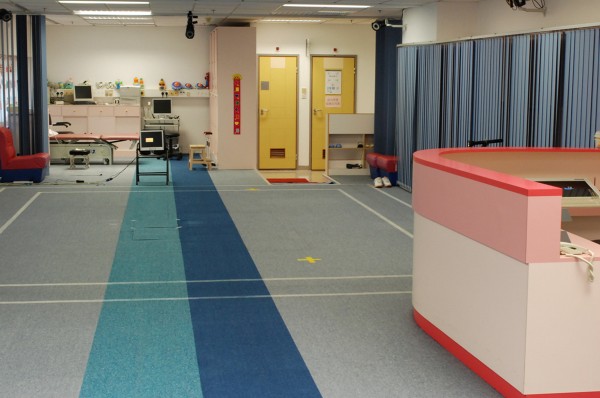
Gait Laboratory.